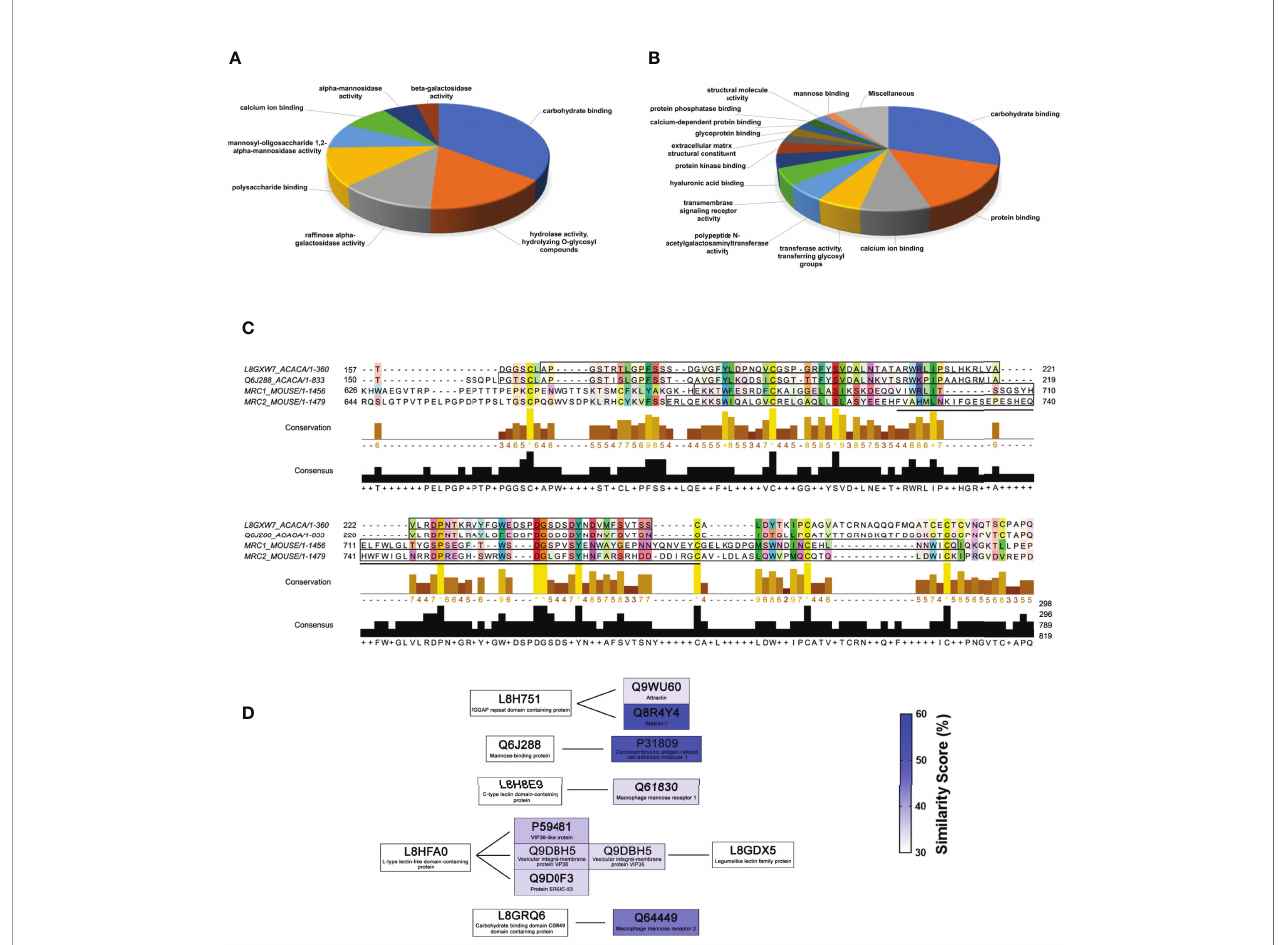
FIGURE 11 | Mannose-binding proteins from Acanthamoeba castellanii and RAW macrophages exhibited identity in domains with lectin properties. Proteins identi fi ed in MPPs of (A) A. castellanii (Ac) and (B) RAW 246.7 macrophages were annotated using the DAVID annotation tools and classi fi ed according to their molecular functions. For both MPPs pools, carbohydrate binding proteins comprised the main category, (C) In silico alignment of the Ac transmembrane proteins MBP (L8GXW7) and MBP1 (Q6J288) with the RAW receptors Mrc1 (Q61830) and Mrc2 (Q64449), using the multiple sequence alignment algorithm, Clustal Omega by Jalview Software. Amino acids on colored background show highly conserved residues. The DUF4114 domains of Ac proteins and C-type lectin-like domains of RAW receptors are highlighted by a black rectangle, while the domains equivalent to the secondary structure of ConA-like lectins/glucanases superfamily are indicated by black underlining. (D) From the MPPs identi fi ed in Ac , six displayed high similarity to proteins also found in the macrophage MBPs pools, suggesting molecular